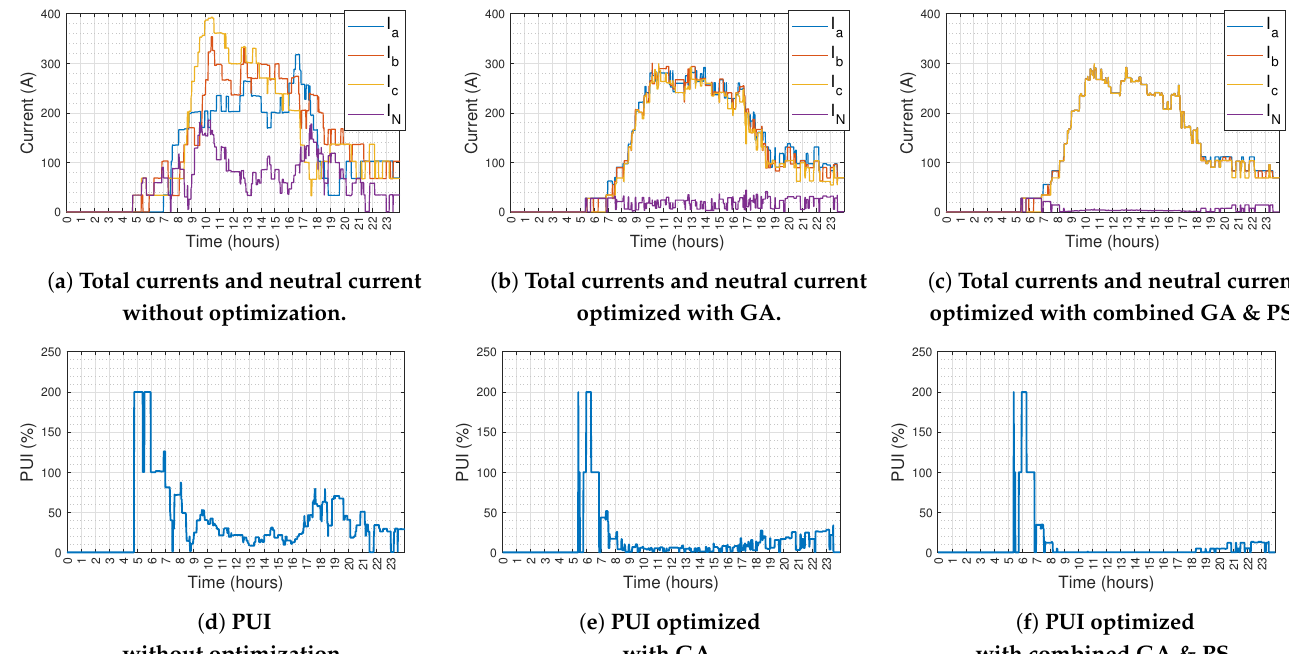
Figure 15. Convergence speed of combined GA & PS. ( a ) Convergence speed of GA. ( b ) Convergence speed of PS.